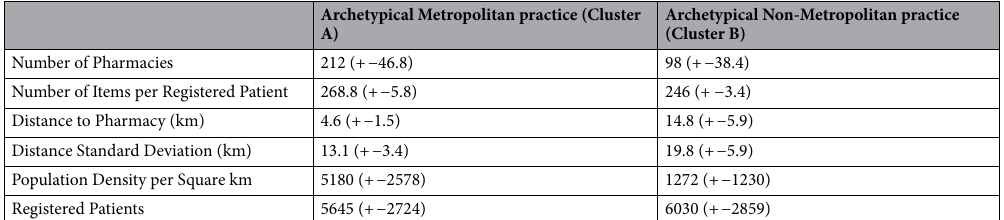
Table 3. Archetypical characteristics each cluster (i.e. Centroid Feature Values) for the period April 2018– March 2019.